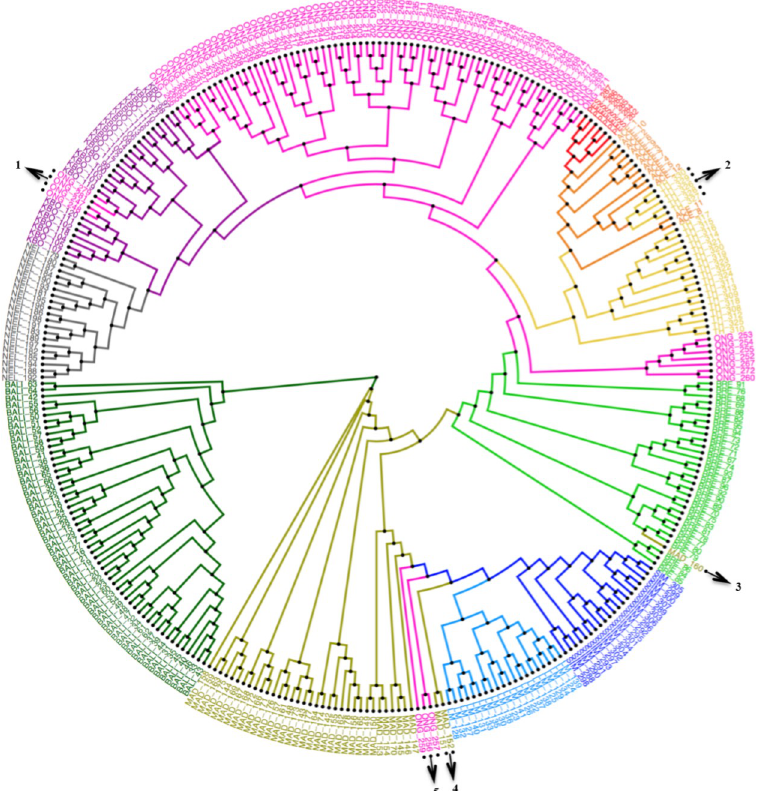
Fig 2. Phylogeny of Indonesian cattle breeds in related with Nelore, zebu in Thailand, and representative taurines (Simmental and Limousine). The phylogeny was rooted in Bali cattle (domesticated Bos javanicus ). Colors were used to define the cattle breeds, i.e. dark green for Bali, olive green for Madura, chartreuse for Jabres, pink for Ongole grade, purple for Kebumen ongole, red for Pesisir, orange for Aceh, yellow for zebu in Thailand, dark grey for Nelore, dark blue for Simmental, and light blue for Limousine. Individual outliers that respect to their breeds were marked with numbered arrows (1 to 5) and described in the Results part.